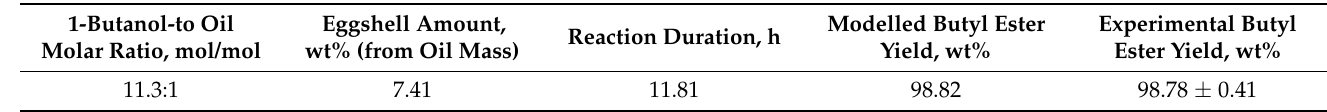
Table 4. Optimal conditions for rapeseed oil butyl ester production, and modelled and experimental ester